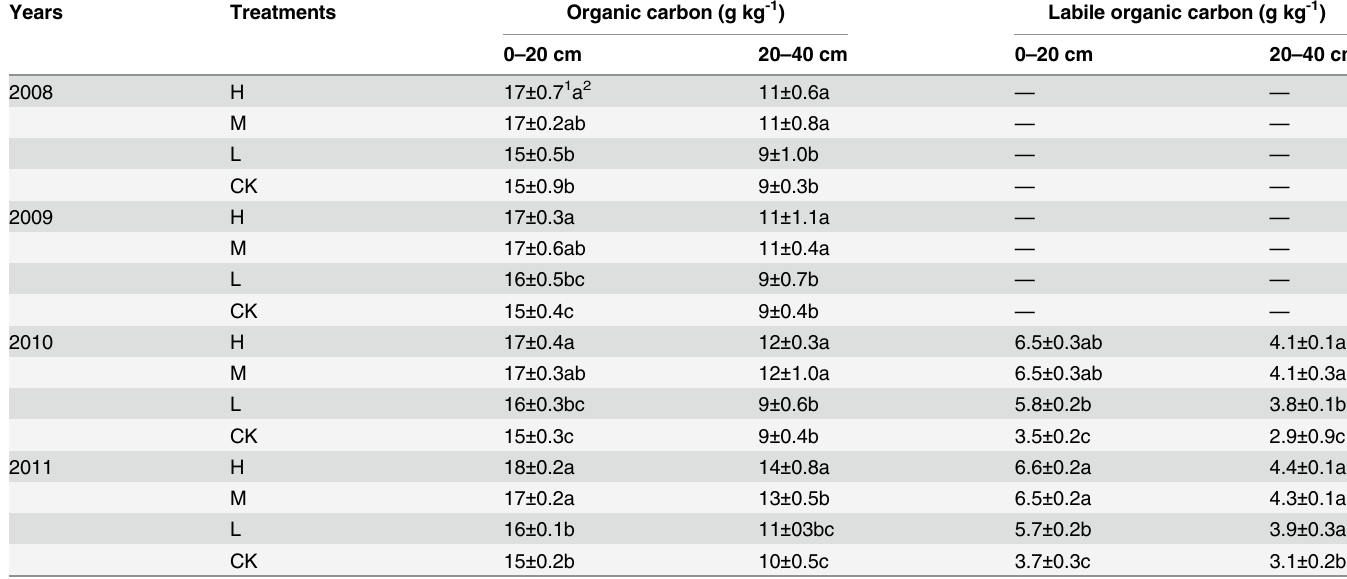
Table 4. Soil carbon content under different wheat straw incorporation treatments in 0 – 20 and 20 – 40 cm soil layers from 2008 to 2011.